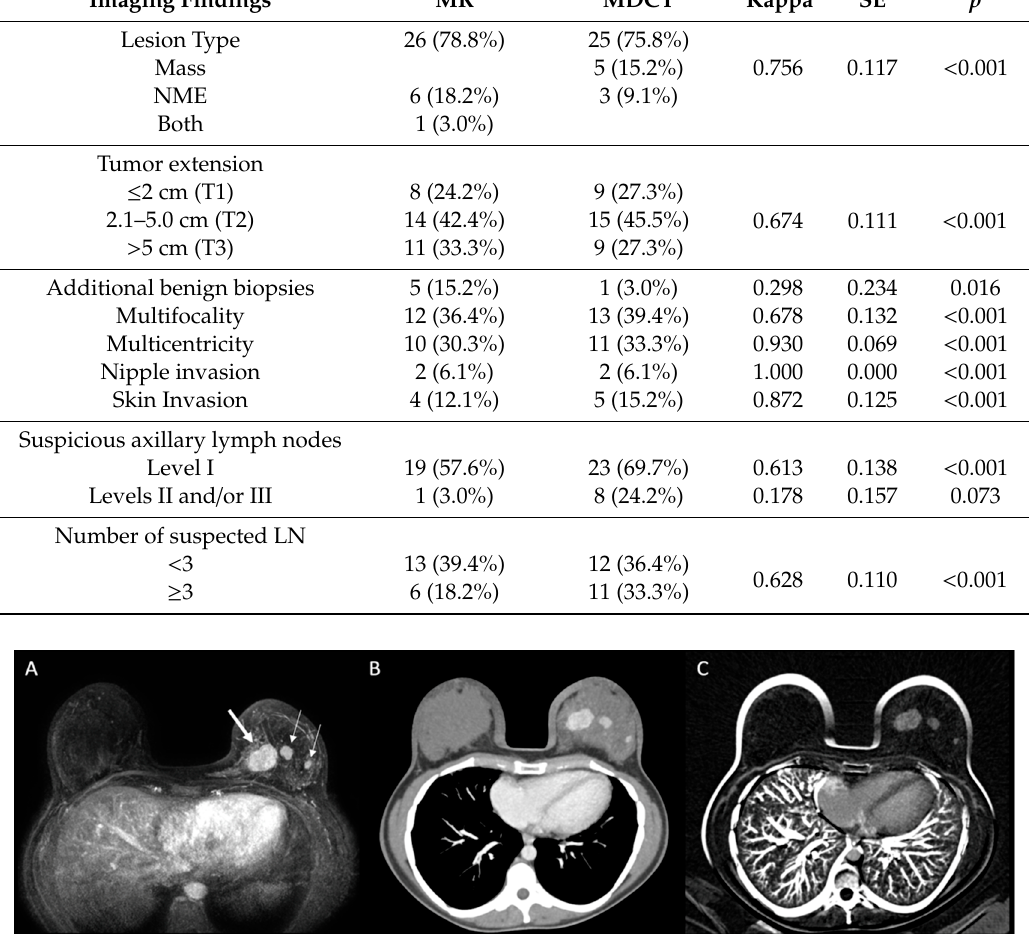
Figure 3. Patient with multicentric invasive breast carcinoma in the left breast. Breast MRI ( A ) identified the main tumor (thick arrow) and two additional lesions on the same breast (thin arrows), which were also identified on MDCT (( B ): post-contrast; ( C ): subtraction). Table 1. Imaging findings on breast MRI and MDCT in breast cancer patients ( n = 33).